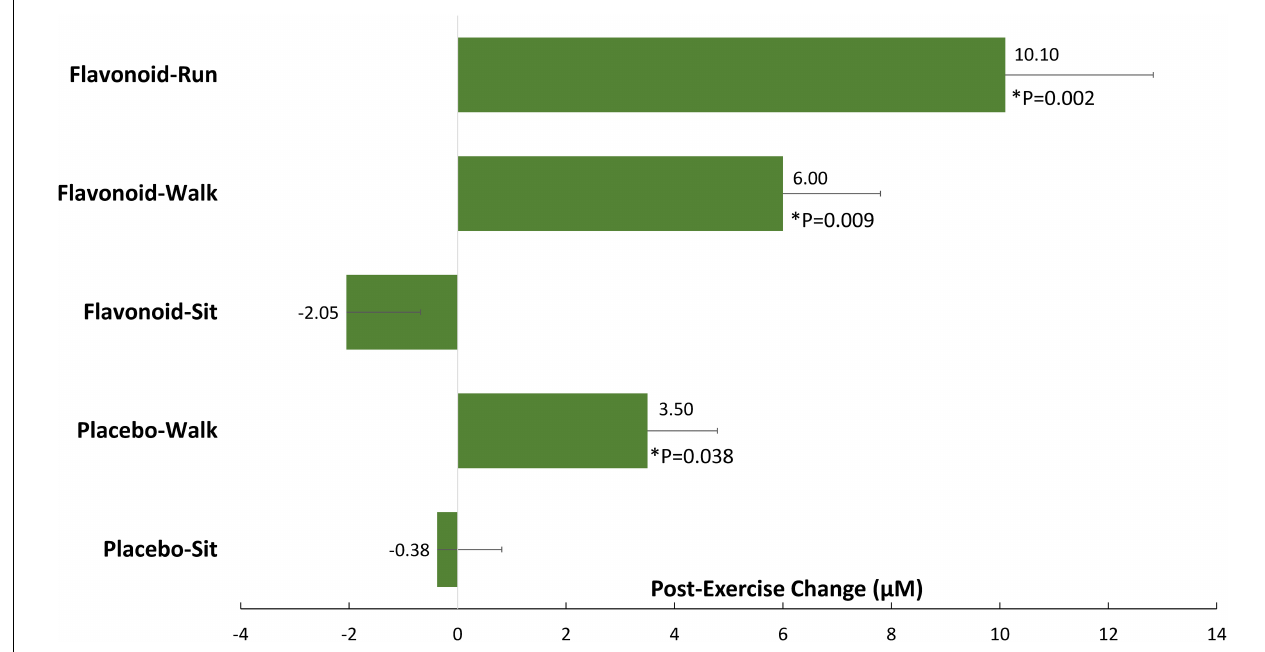
FIGURE 3 | Post-exercise change for 15 selected and grouped plasma gut-derived phenolics. P -values indicate contrasts with the placebo–sit group. Data are represented as means with standard errors of the mean. *indicates a significant difference with the placebo-sit group ( P values).